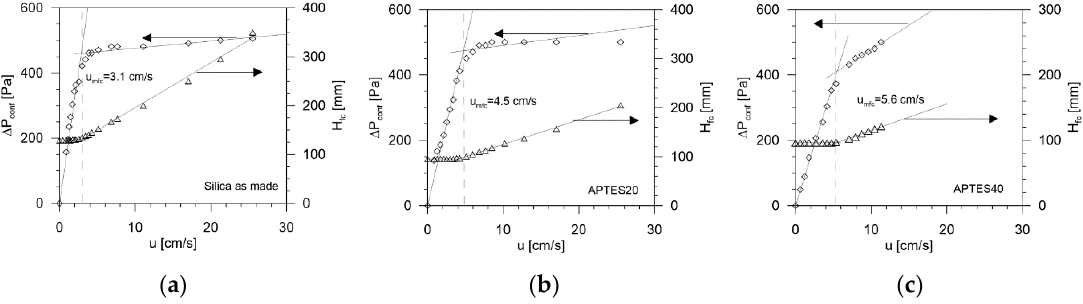
Figure 9. Typical diagram of fluidization tests in a confined bed: pressure drop, Δ P conf , and heigh of